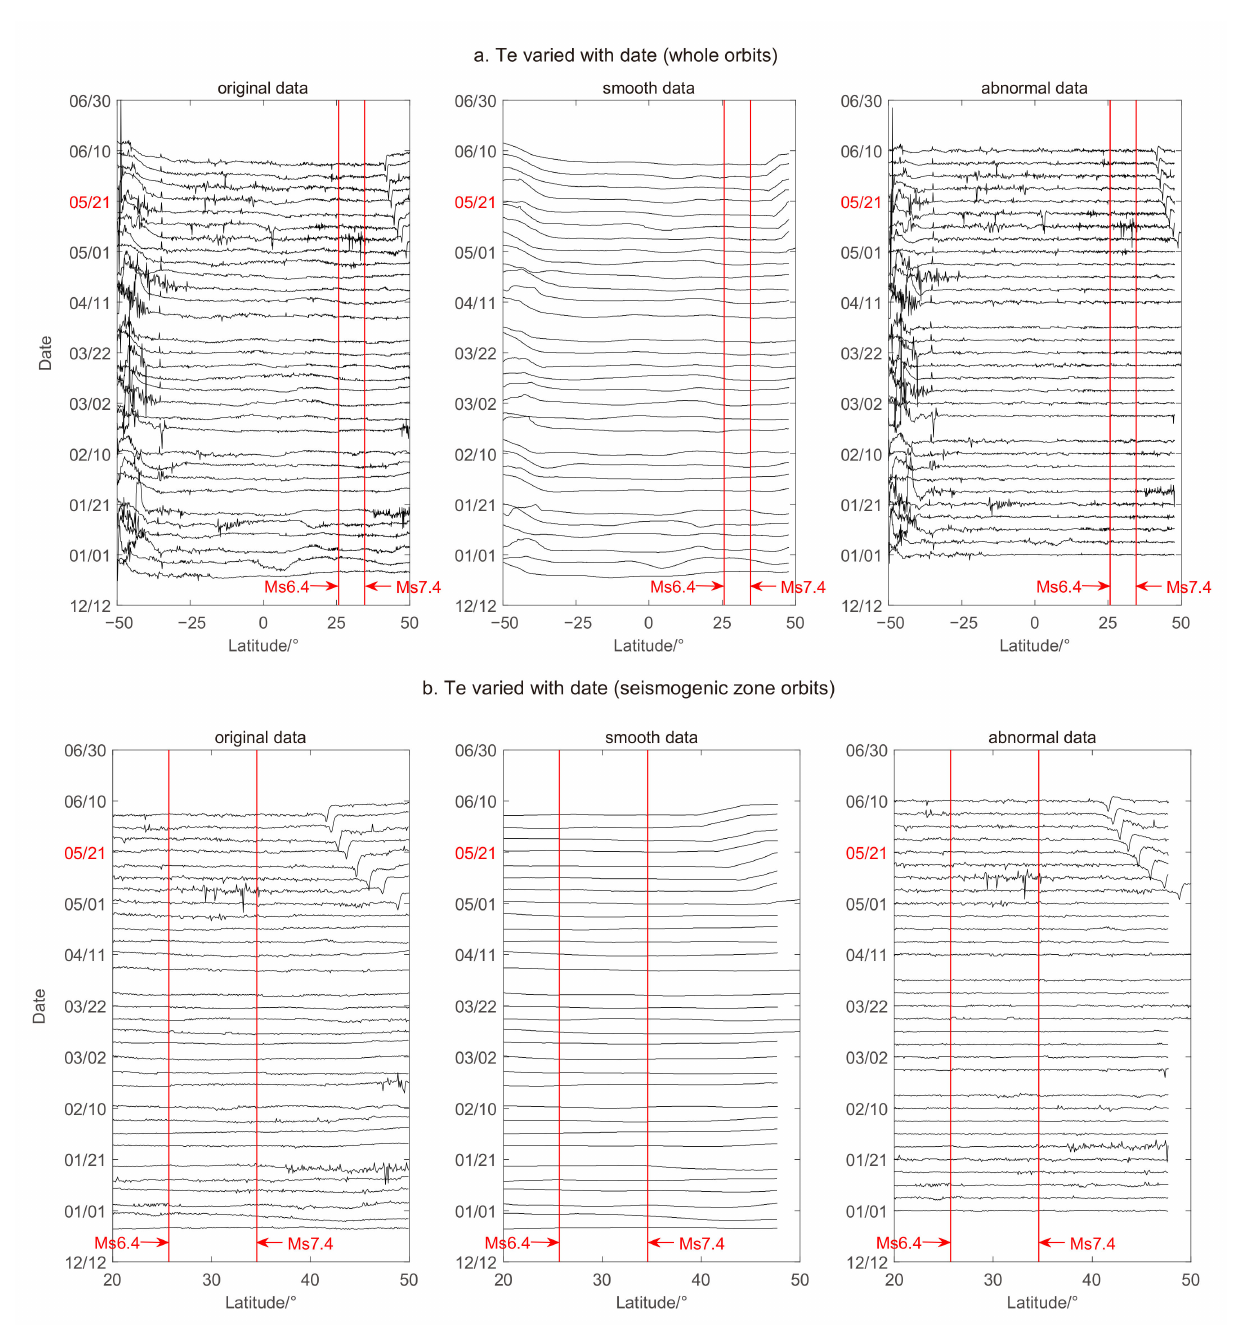
Figure 4. Te varied with data from 1 January 2021 to 14 June 2021 ( a ). Whole orbits; this range is from 50 ◦ S to 50 ◦ N. ( b ). Seismogenic zone orbits; the seismogenic zone is 21 ◦ N to 49 ◦ N, and we actually use 20 ◦ N to 50 ◦ N. In each figure, the first subfigure represents the original data, the second represents the smooth data, and the third represents the abnormal data. Red lines indicate the latitude of the earthquakes. We take the date of the first earthquake (Yangbi earthquake, 21 May) as the date of these two earthquakes (in